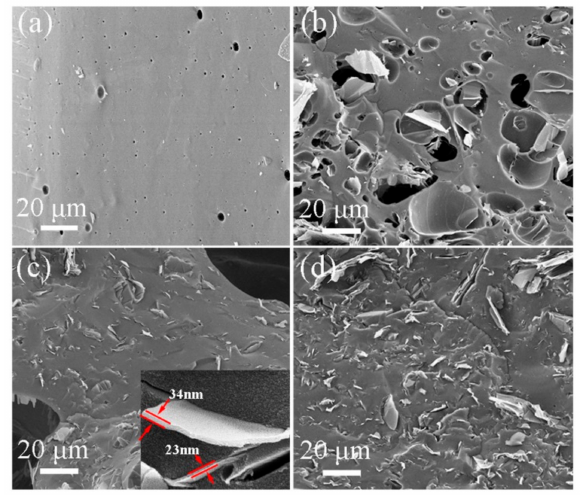
Figure 7. Scanning electron microscope (SEM) images of GNPs / PF composites pyrolyzed at 1000 ◦ C with di ff erent FG contents exfoliated 16 times: ( a ) 0 wt.%, ( b ) 3 wt.%, ( c ) 5 wt.% (the inset shows the single exfoliated GNP), and ( d ) 8